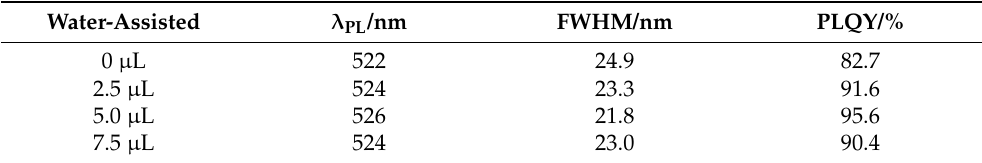
Table 1. Summary of optical properties of MAPbBr 3 PeQDs prepared without water (0 µ L) and with water (2.5–7.5 µ L).